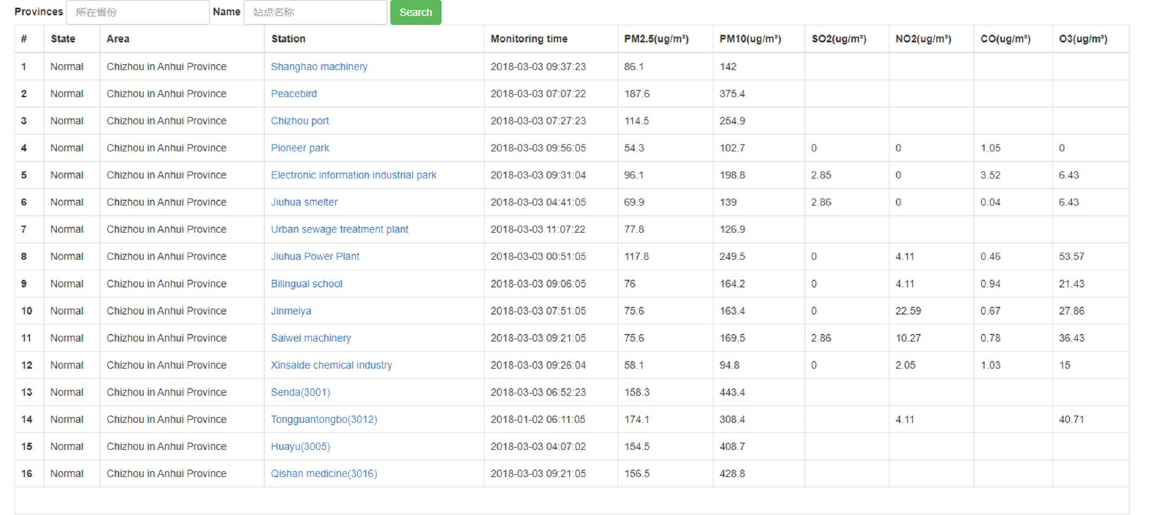
Figure 2. The statistical interface of the latest monitoring data of each site of the monitoring and early warning